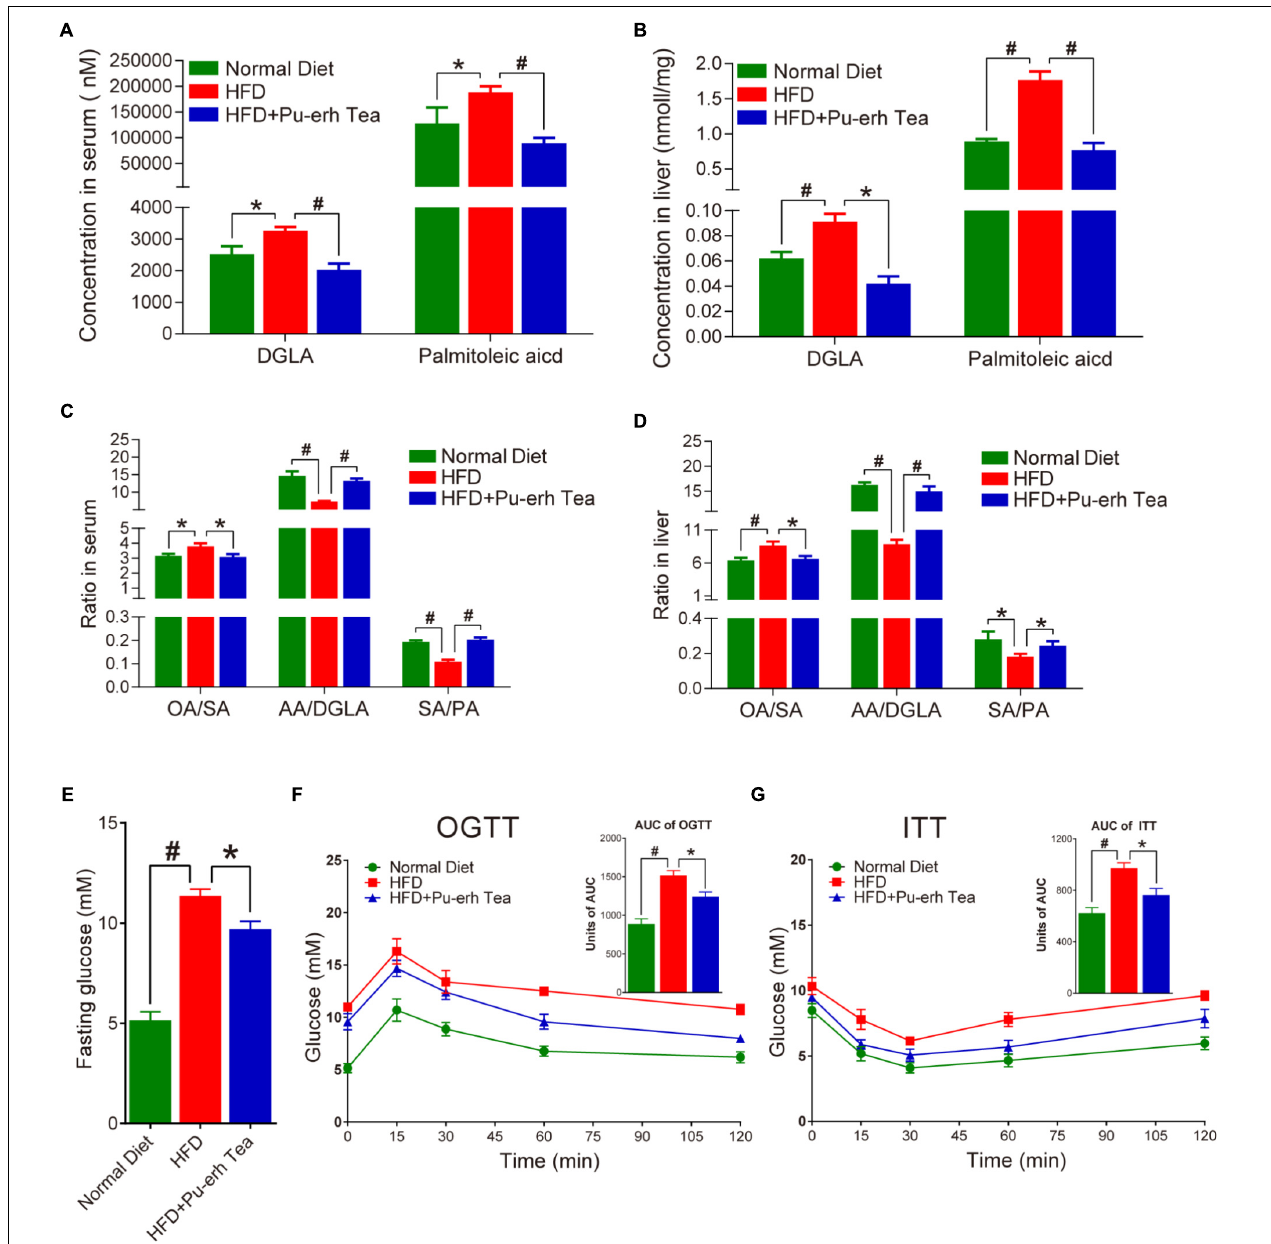
FIGURE 4 | Pu-erh tea altered FFA biomarker of obesity. (A) Concentrations of DGLA and palmitoleic acid in serum of mice fed with control diet, HFD, and HFD with 450 mg/Kg/day Pu-erh tea for 22 weeks. (B) Concentrations of DGLA and palmitoleic acid in liver of mice fed with control diet, HFD, and HFD with 450 mg/Kg/day Pu-erh tea for 22 weeks. (C) Ratios of OA/SA, AA/DGLA, and SA/PA in serum of mice fed with control diet, HFD, and HFD with 450 mg/Kg/day Pu-erh tea for 22 weeks. (D) Ratios of OA/SA, AA/DGLA, and SA/PA in liver of mice fed with control diet, HFD, and HFD with 450 mg/Kg/day Pu-erh tea for 22 weeks. (E) Fasting glucose level in serum of mice fed with control diet, HFD, and HFD with 450 mg/Kg/day Pu-erh tea for 22 weeks. (F) Oral glucose tolerance test (OGTT) and the related area under the curve (AUC) of mice fed with control diet, HFD, and HFD with 450 mg/Kg/day Pu-erh tea at the end of week 18. (G) Insulin tolerance test (ITT) and the related area under the curve (AUC) of mice fed with control diet, HFG, and HFD with 450 mg/Kg/day Pu-erh tea at the end of week 19. Data were expressed as mean ± SEM and differences were assessed by Mann–Whitney U test, ∗ p < 0.05, # p < 0.005.